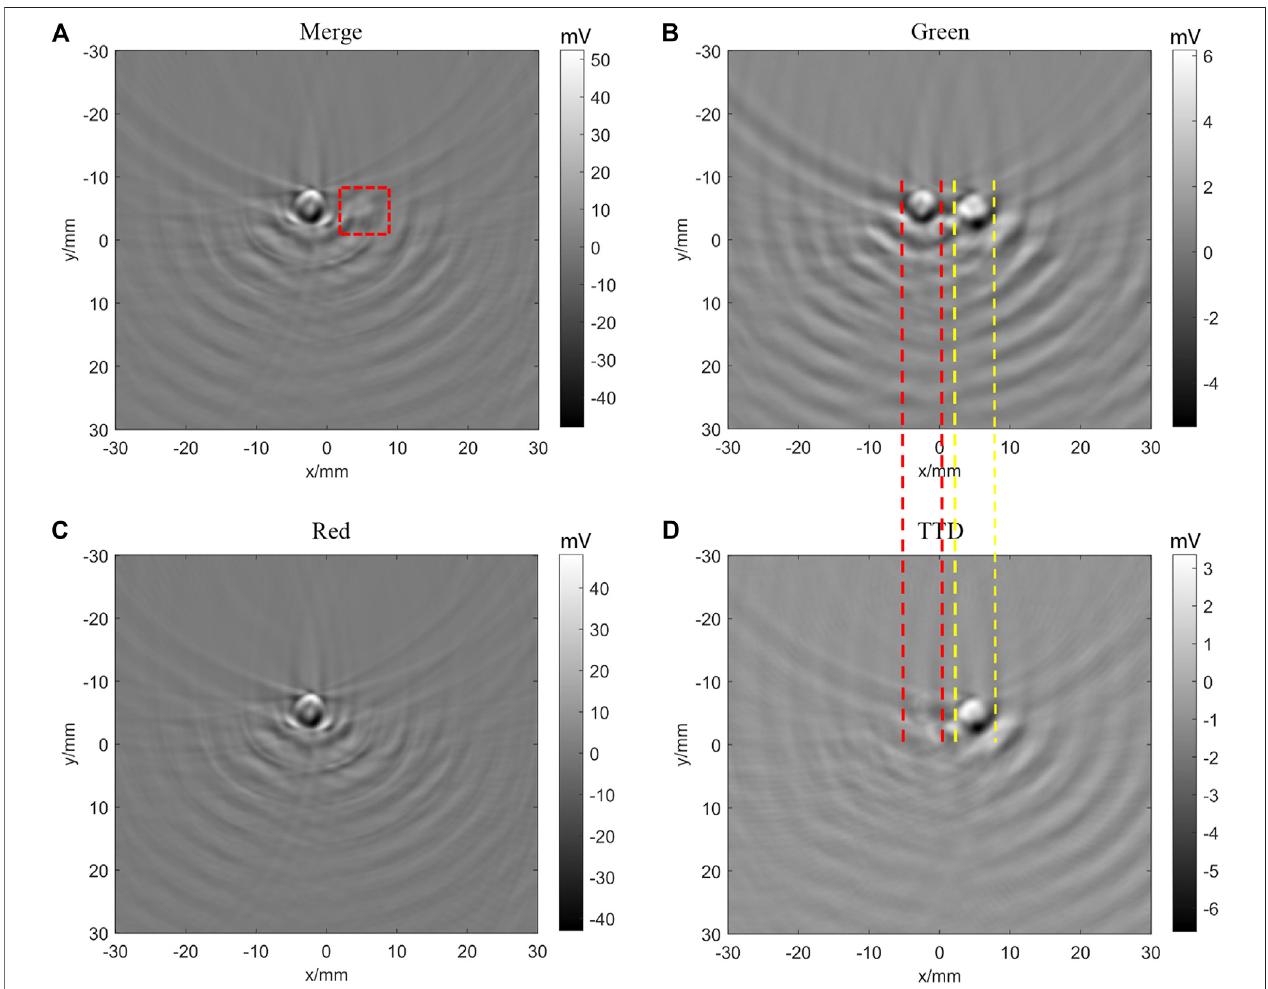
FIGURE 9 | TTD images of black ink (left) and PtOEP (right) with 0 µs time delay and 50 signal averages. (A) Photoacoustic image stimulated by 532 and 740 nm combinedbeam; thered lineframe istheimagingareaofPtOEP. (B) Photoacousticimagestimulatedby532 nm beam. (C) Photoacoustic imagestimulated by740 nm beam. (D) TTD images.